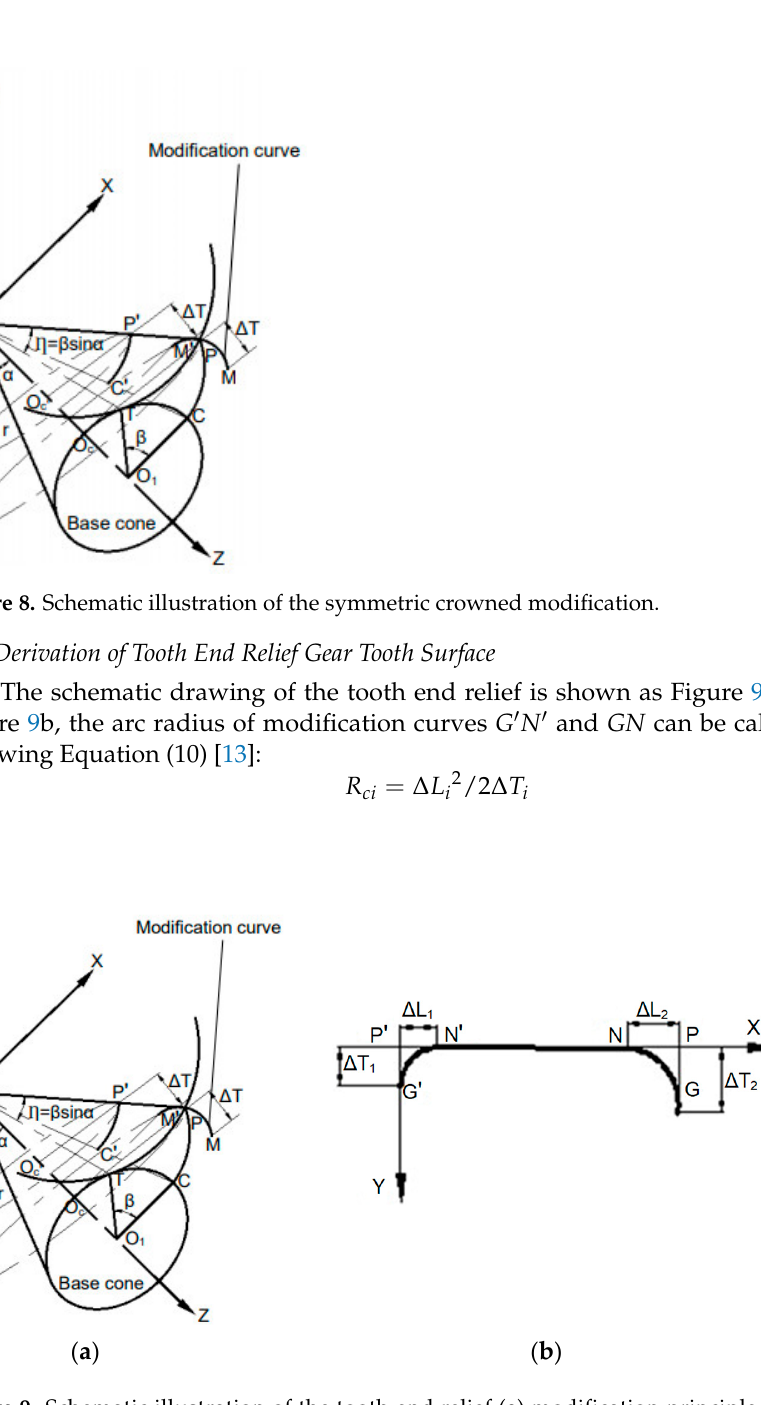
Figure 9. Schematic illustration of the tooth end relief ( a ) modification principle ( b ) modification curves G ′ N ′ and GN .